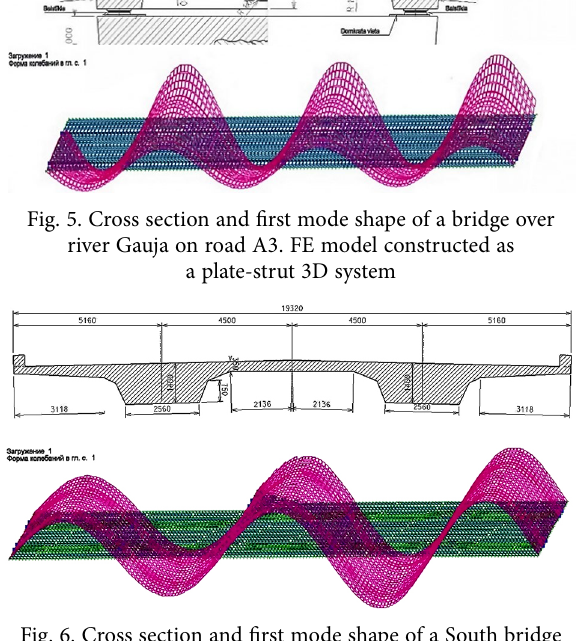
Fig. 6. Cross section and first mode shape of a South bridge overpass Nr. 4–3. FE model constructed as a plate 3D system